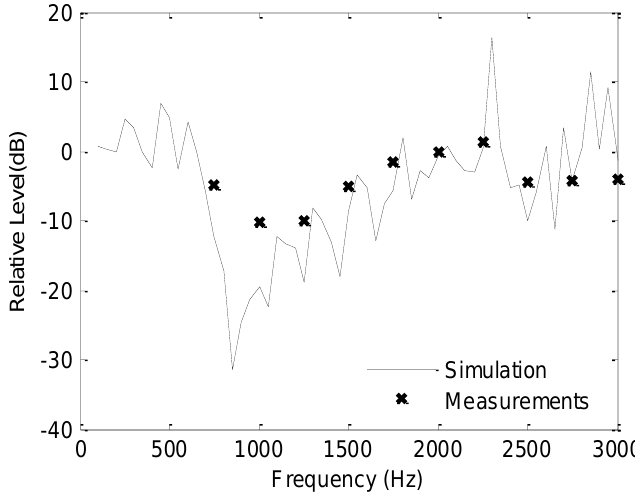
Figure 2. Comparison between the RL spectra of simulation and measurements in the validation case. X-marker: measurements in the 1/10 scale model (after Sessler and West [2]). Solid line: simulation with the geometry and boundary conditions in the scale model.